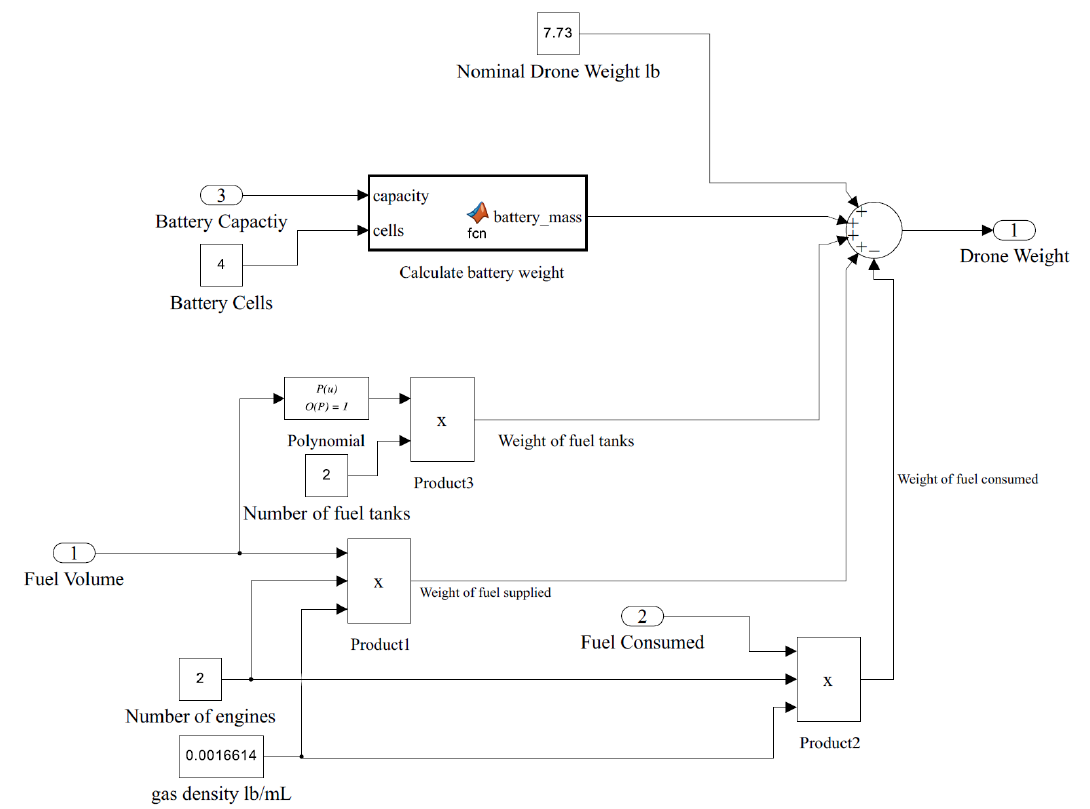
Figure 15. Drone weight calculation.